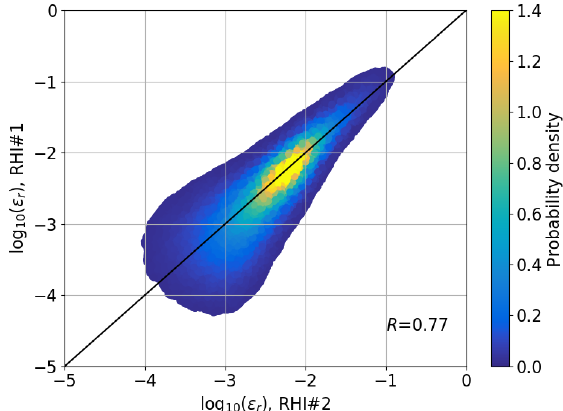
Figure 9. Comparison of all estimates of ε in the RHI plane for 9–15 June 2017 between RHI#1 and RHI#2. The color scales represent the probability of occurrence of a measurement point. The black line is the line of identity. Data points with probability density below 0.02 are not